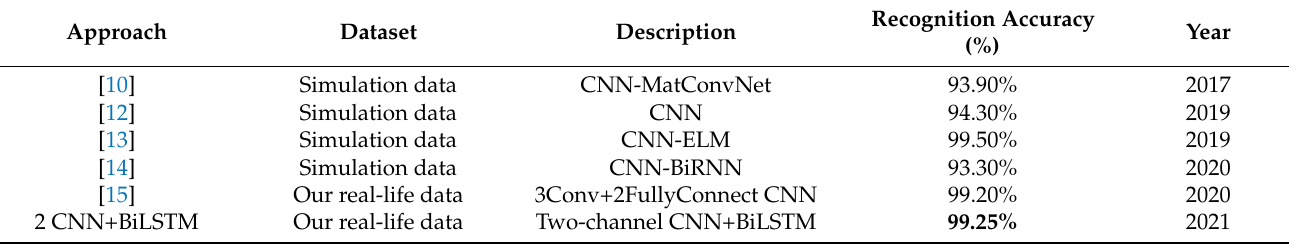
Table 8. Comparison of for HRRP recognition performance for various